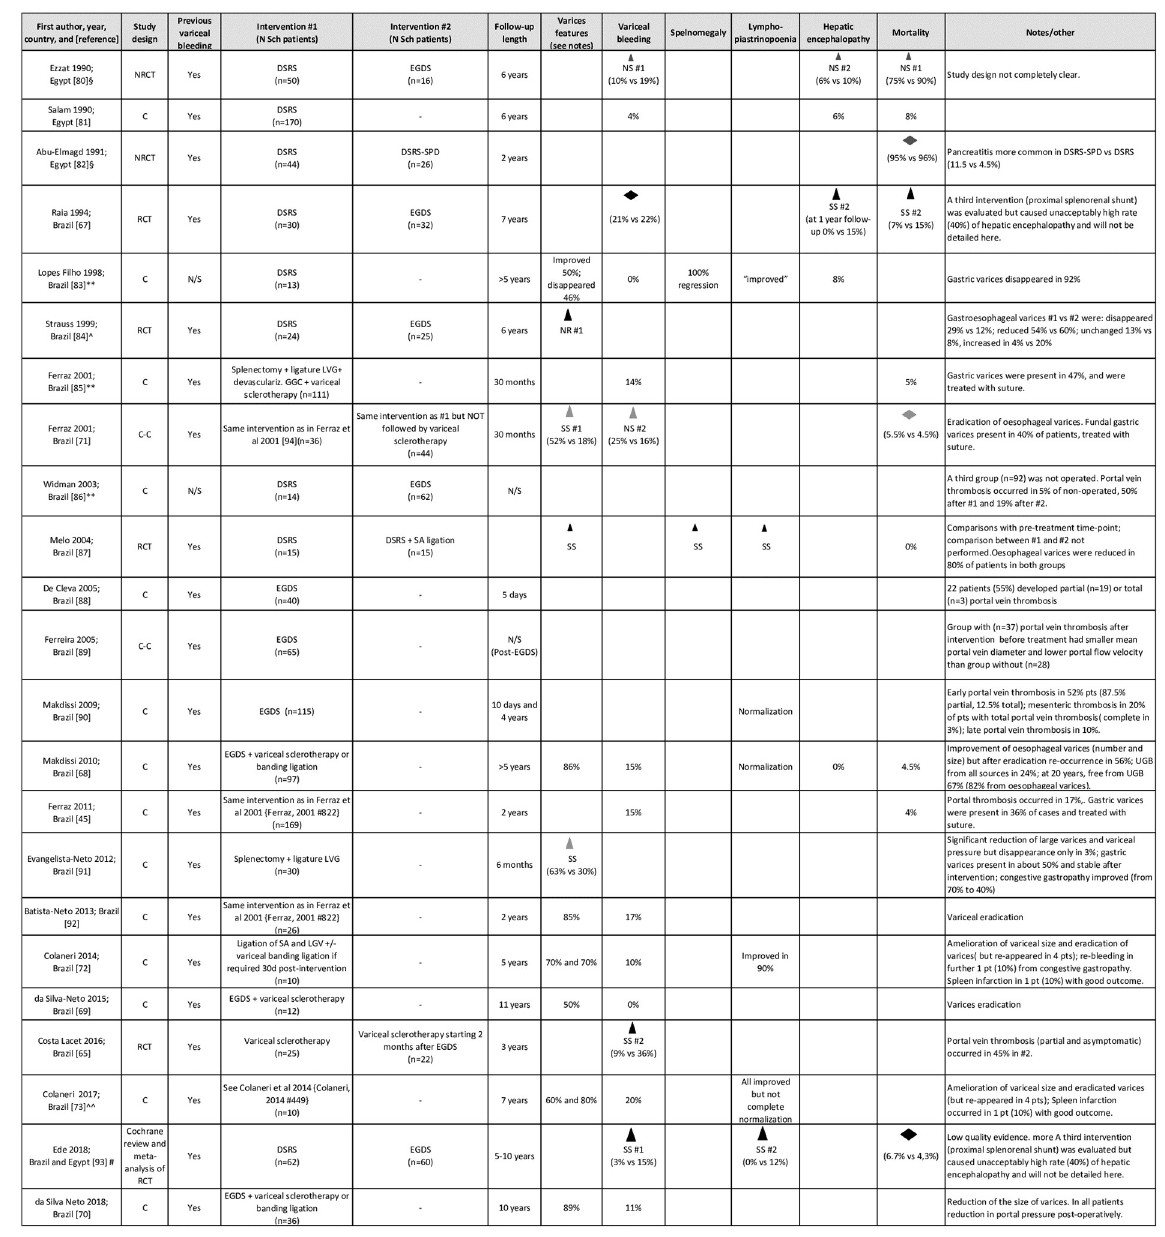
Fig 5. Direction effect chart summary of the included publications describing patients with hepatosplenic schistosomiasis treated with classic surgical interventions. Evaluation of all outcomes refers to the end of follow-up. DSRS, distal splenorenal shunt; DSRS-SPD, DSRS with splenopancreatic disconnection; EGDS, esophagogastric devascularization procedure with splenectomy; GGC, great gastric curvature; LGV, left gastric vein; N/S, not specified; SA, splenic artery; UGB, upper gastrointestinal bleeding. �� Data extracted from abstract. §Study included also patients with other pathologies; as not all outcomes were compared between intervention groups in patients with schistosomiasis-only infection, principal findings refer to those parameters which could be extracted for this latter group. ^Subgroup analysis of the Raia and colleagues’ 1994 study. ^^Expanded follow-up of the cohort of Colaneri and colleagues’ 2014 study. #Cochrane review including 2 studies, Raia and colleagues [67] from Brazil and Gawish and colleagues [94] from Egypt (this latter study was retrieved by our literature search, but full text was unavailable). Column of the table. C, Cohort study. C–C, Case–Control study. RCT, Randomized Clinical Trial. NRCT, Non-Randomized Clinical Trial. UGB, upper gastrointestinal bleeding. Triangle orientation indicates direction of outcome: upward = amelioration in respect to other intervention or baseline, horizontal = no difference between interventions or from baseline. Triangle size indicates sample size per (smallest) group: small � 20 pts, medium 21–49 pts, large � 50 pts. Triangle color indicates quality of result based on study design and source: black = RCT, dark gray = NRCT, light gray = C–C, dotted = C, white = data from abstract. SS, statistically significant, NS, not statistically significant, NR, statistical analysis not reported. #n = intervention indicated in the corresponding “Intervention #n” to which the outcome direction refers